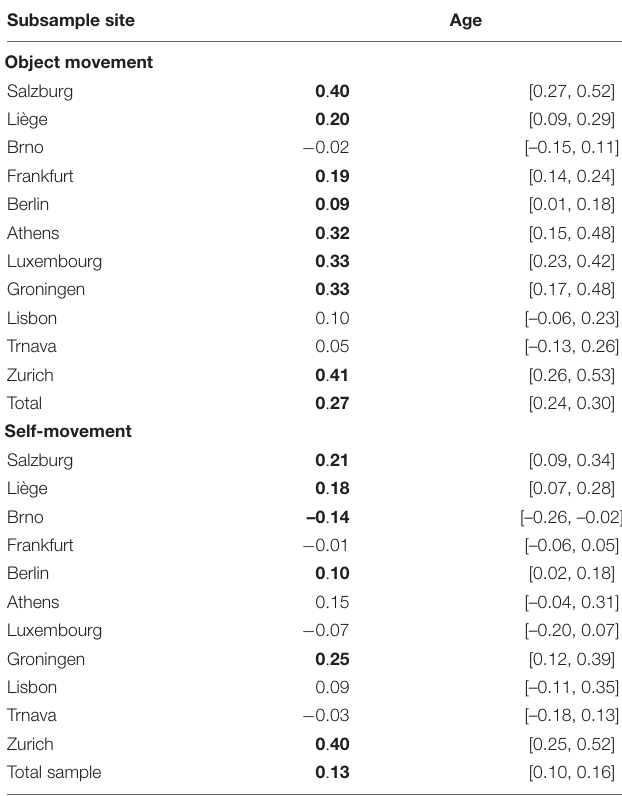
TABLE 2 | Pearson correlations ( r , 95% CI ) between motor competence areas and age, stratified by